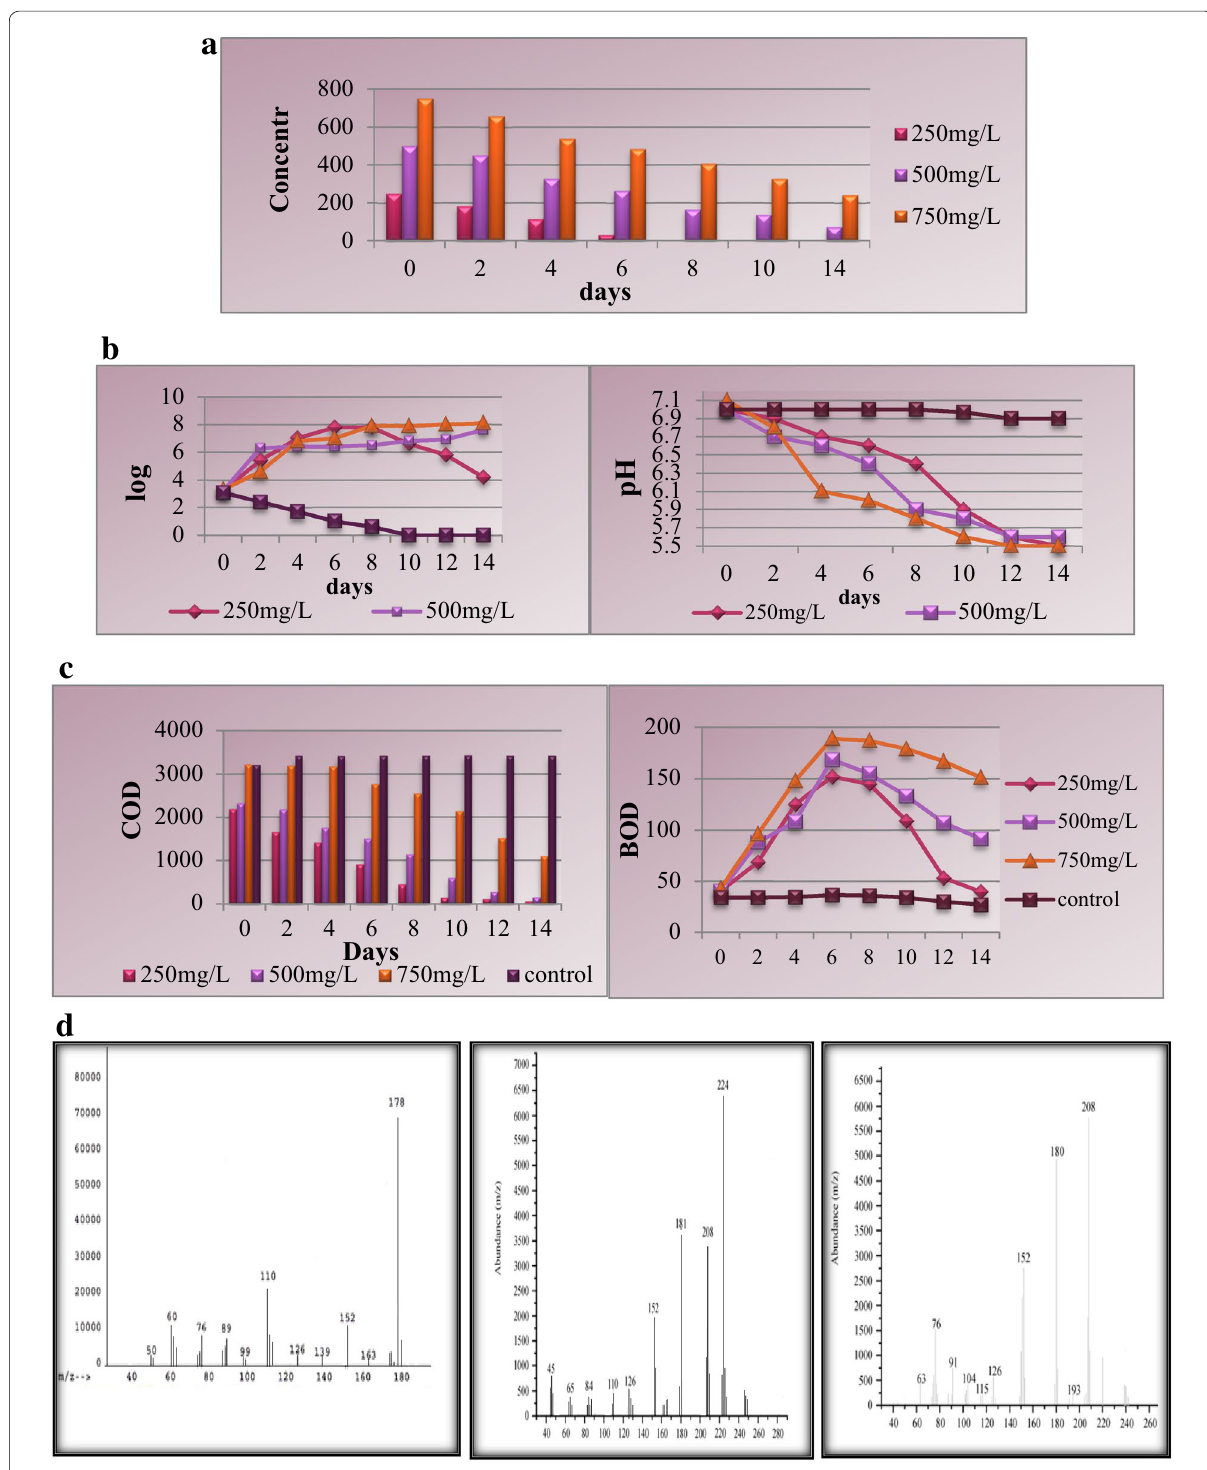
Fig. 2 a Degradation of anthracene by microbial consortium in TMM. b Variation in viable count and variation in pH during bioremediation of anthracene by microbial consortium in TMM. c Variations in COD and BOD during bioremediation of anthracene by microbial consortium in TMM. d Mass spectra of Anthracene ( m/z identification-178), 1-methoxy-2-hydroxy-anthracene ( m/z identification-224), and Anthraquinone ( m/z identifica-